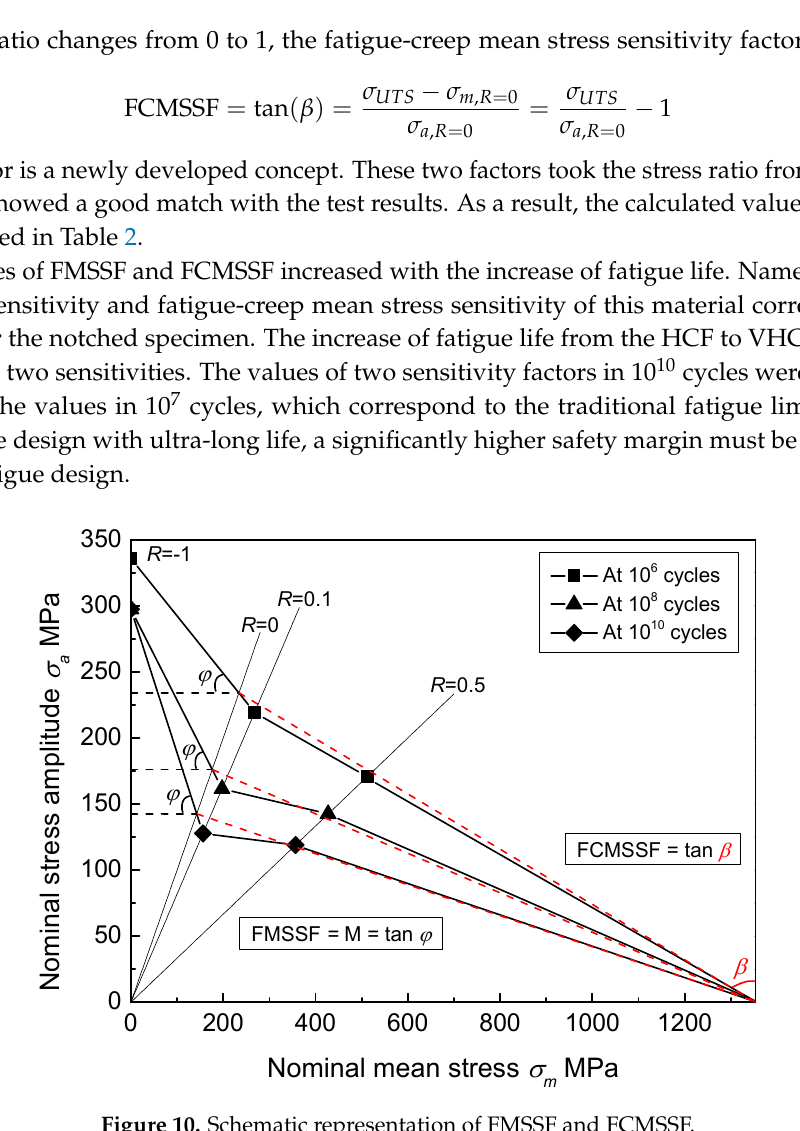
Figure 10. Schematic representation of FMSSF and FCMSSF. Table 2. Values of FMSSF and FCMSSF at different fatigue life.